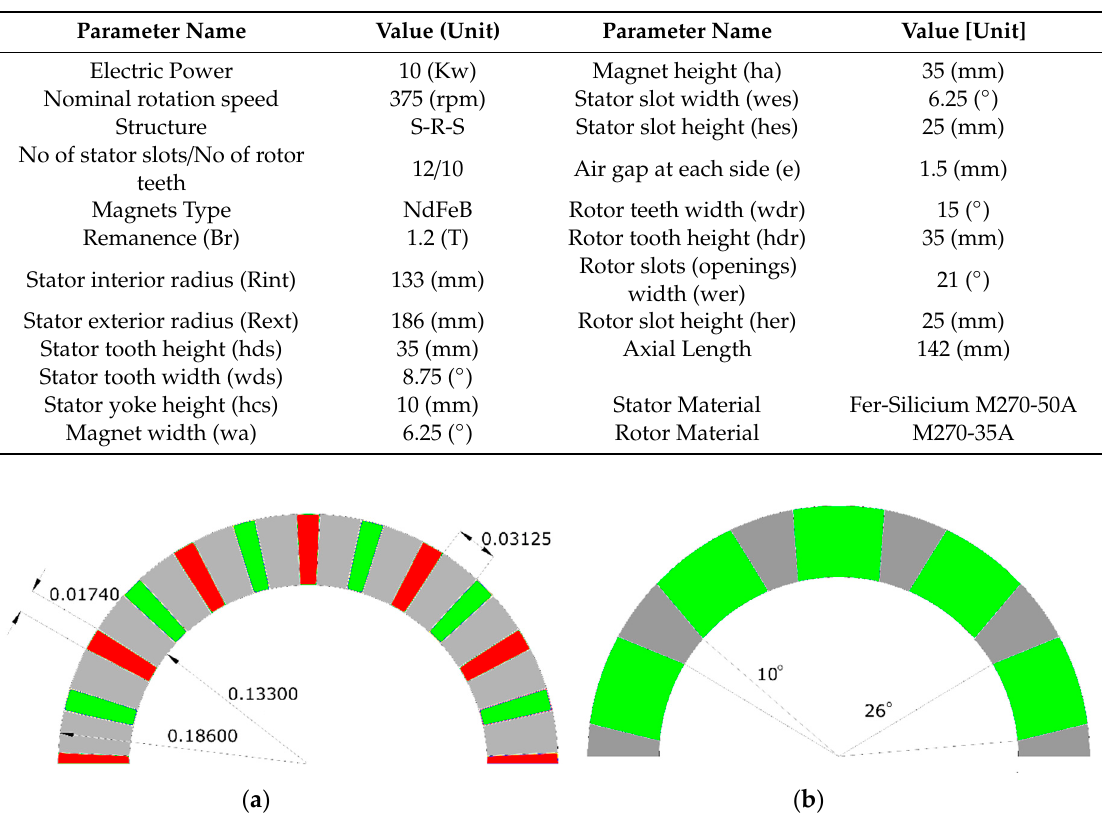
Table 1. The design variables describing the AFSPM prototype.